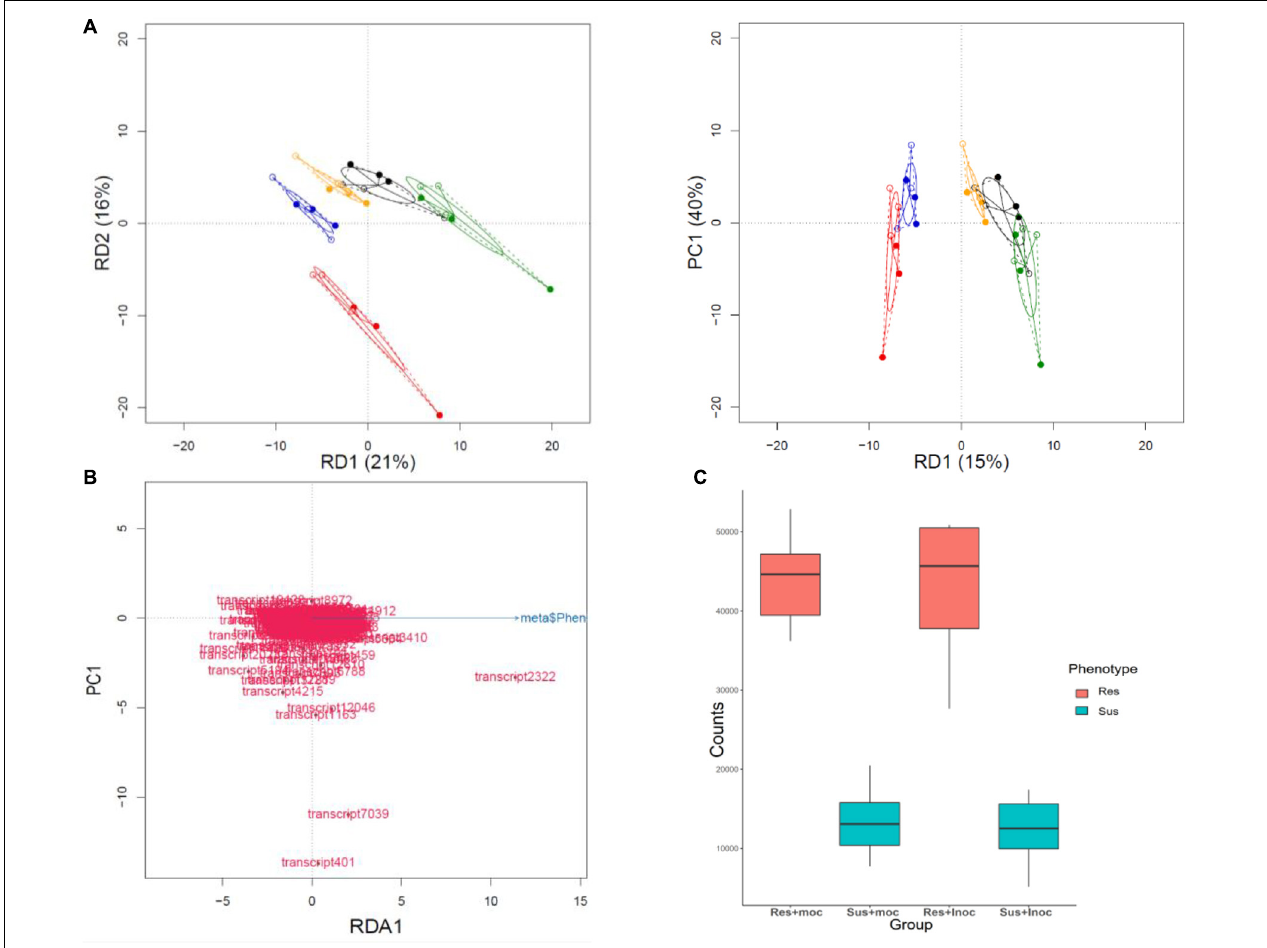
FIGURE 5 | Redundancy analysis of NB-ARC domains. (A) (Genotype) RDA analysis of the genotype effects of NB-ARC domain expression data explains 55% of the variation (four axis only two are depicted here). (Phenotype) the same analysis shows that phenotype explains 15% of the variation that separates the resistant and susceptible phenotypes. (B) NB-ARC sequences contributing to the separation of the phenotypes (Resistant vs Susceptible); transcript2322 has the highest contribution to the separation. A full-length BLAST query of this transcript against the TAIR database returns RPP13 as the best hit (Bit score 216 and E-value 4e-60). (C) Comparison of the expression values (TPM) of transcript2322 reveals that even though this transcript is not differentially expressed due to the experiment, it has significantly higher ( P -value = 0.0003996) base expression in resistant phenotypes before and after the experiment. This could be due to maternal effects or different regulation of the gene in resistant